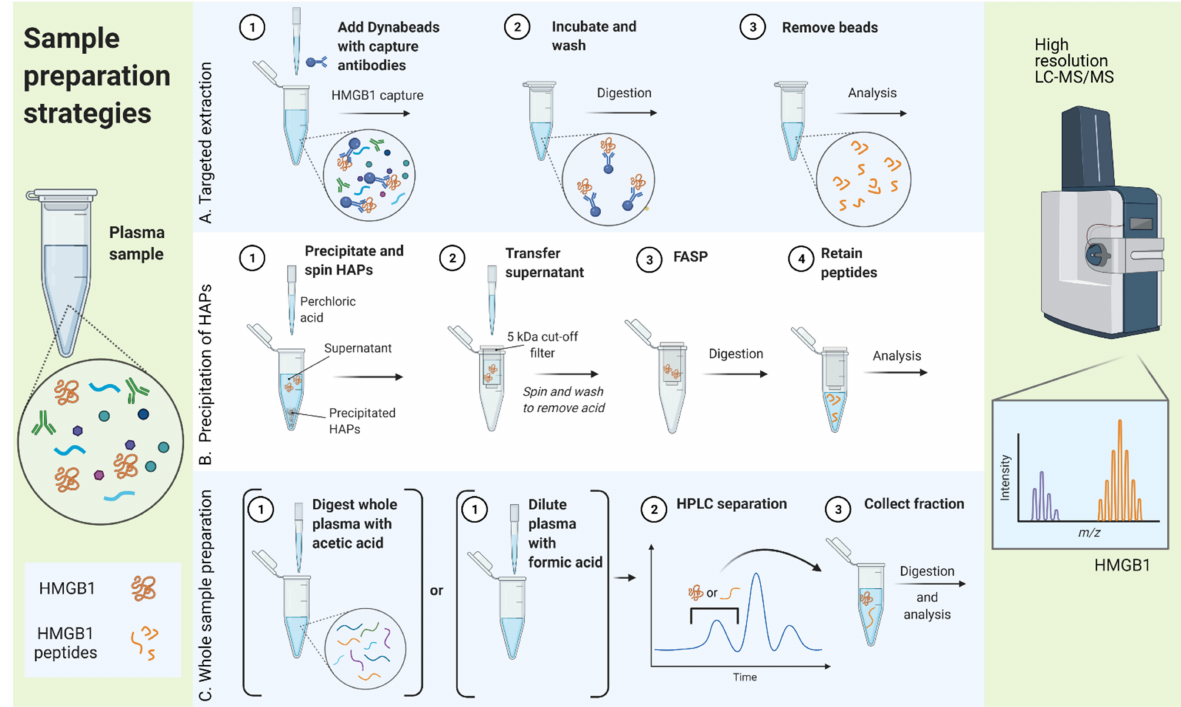
Figure 3. Different sample preparation strategies used to optimize sample clean-up for antibody-free analysis of high mobil- ity group box 1 (HMGB1) in human plasma. FASP, filter aided sample preparation; HAP, high abundance proteins; HPLC, high performance liquid chromatography; LC-MS/MS, liquid chromatography coupled with tandem mass spectrometry. Created with